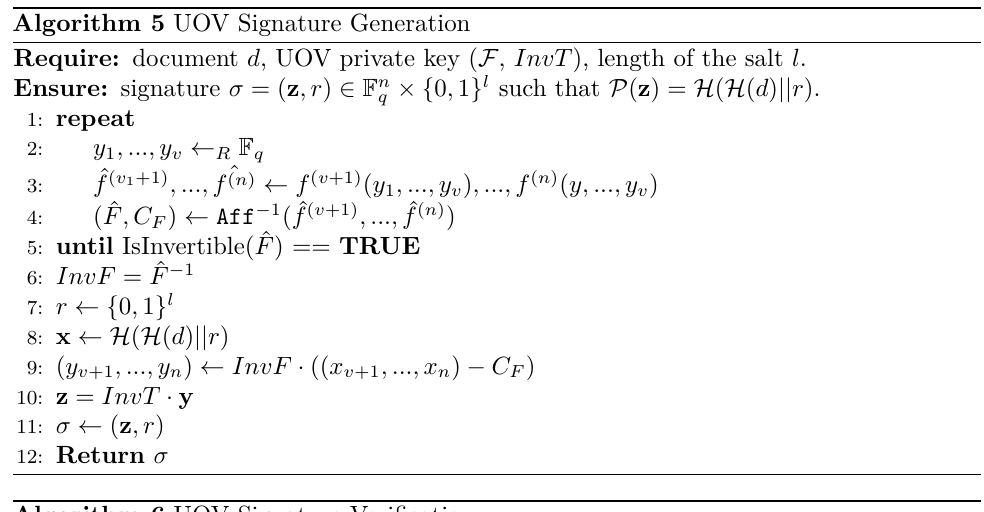
Algorithm 6 UOV Signature